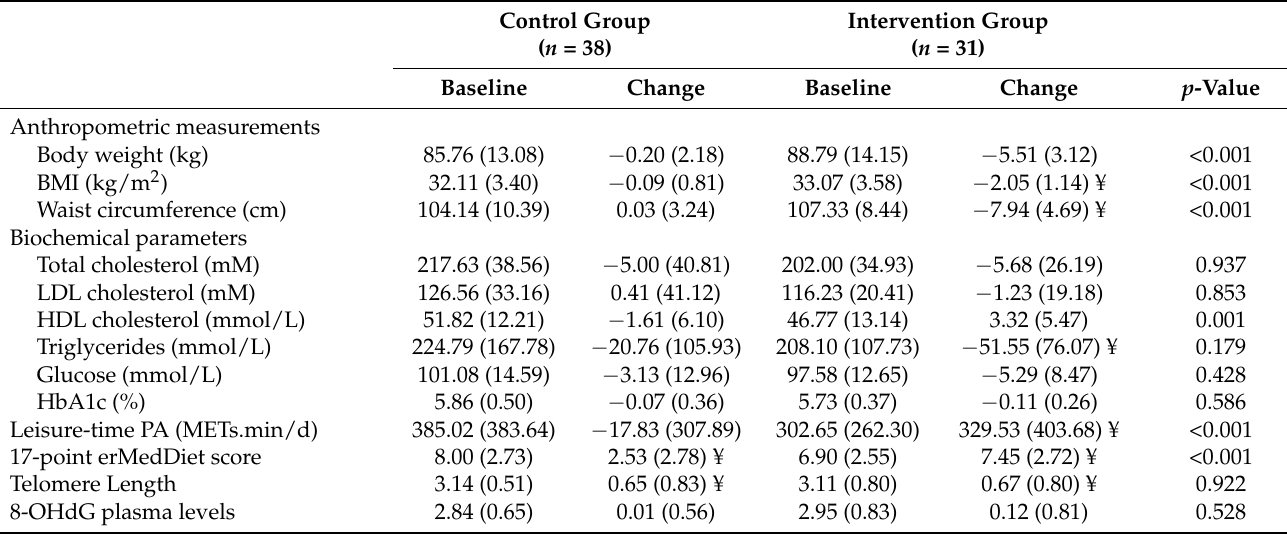
Table 3. Baseline and 1-year changes in anthropometric measurements, biochemical parameters, telomere length, and 8-OHdG plasma levels by treatment